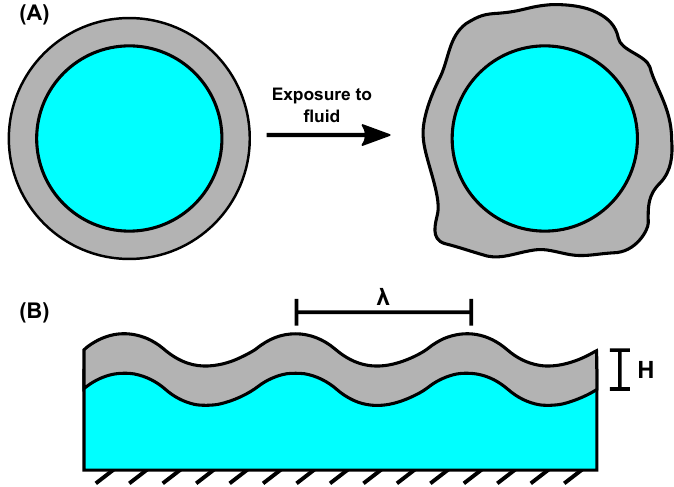
Figure 4. ( A ) A circular core (blue)–shell (grey) hydrogel, before and after exposure to a swelling solution, showing the anisotropy in the buckling formation. ( B ) Surface-attached hydrogel showing the wavelength, λ , and layer thickness